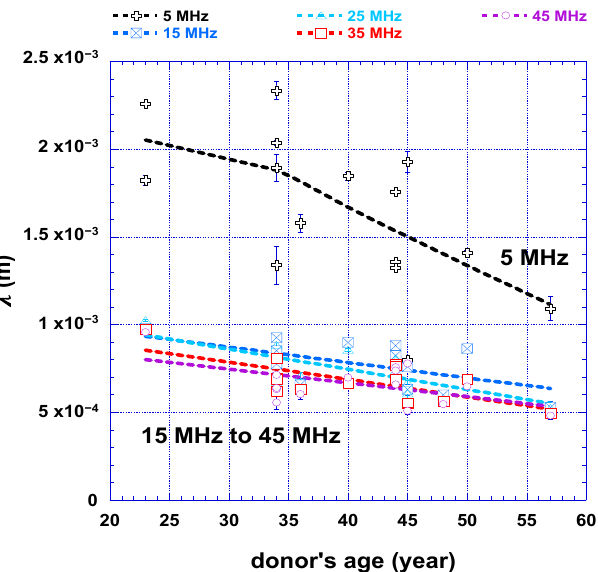
Figure 5. Shear wave wavelength in living skin explants as a function of the donor’s age. The dotted lines represent the penetration depth trends to considered. Skin density is assumed to be 1000 kg/m 3 [78].